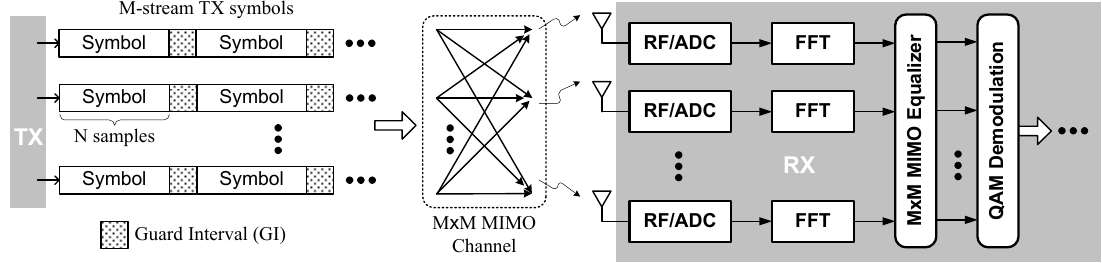
Figure 2. Block diagram for the conventional M × M MIMO-OFDM transmission model.